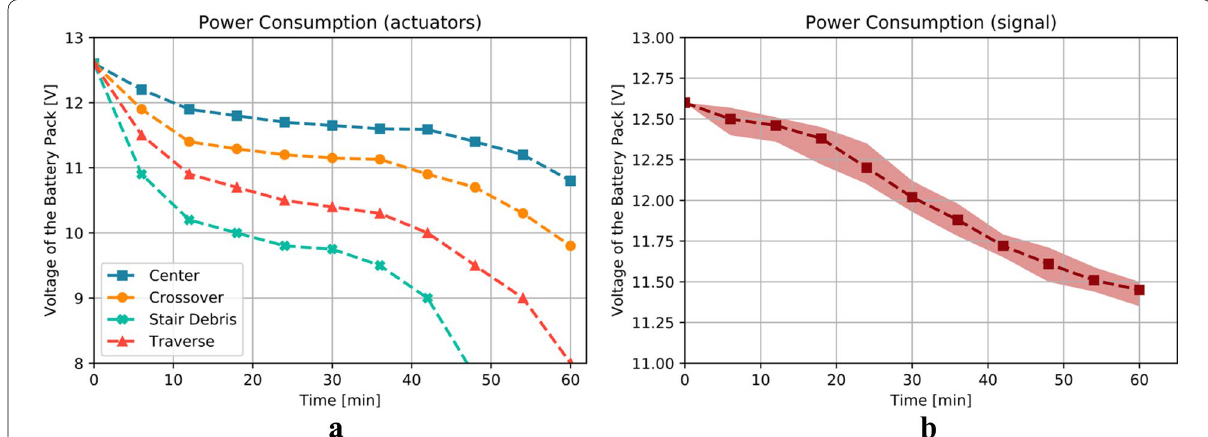
Fig. 19 The discharge pattern of the robot’s battery packs over a course of 60 min: a actuators’ battery pack, and b signal devices’ battery pack